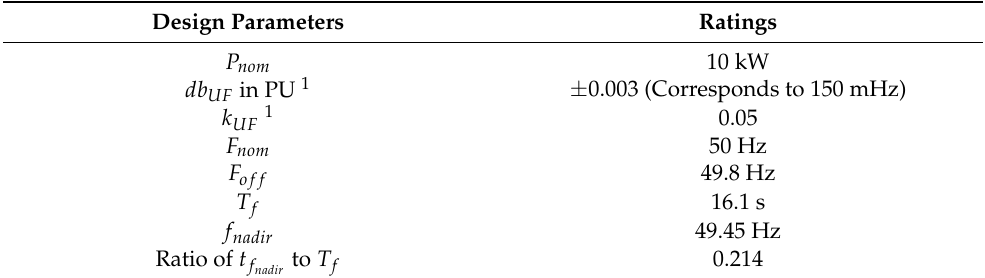
Figure 16. Energy estimation corresponds to the Droop control part and the RoCoF response part, respectively, based on the area under the PFR characteristics and the RoCoF characteristics, respectively. Table 4. Design parameters for Droop control and the proposed TPL